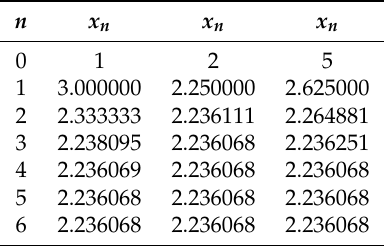
Table 1. Approximation of